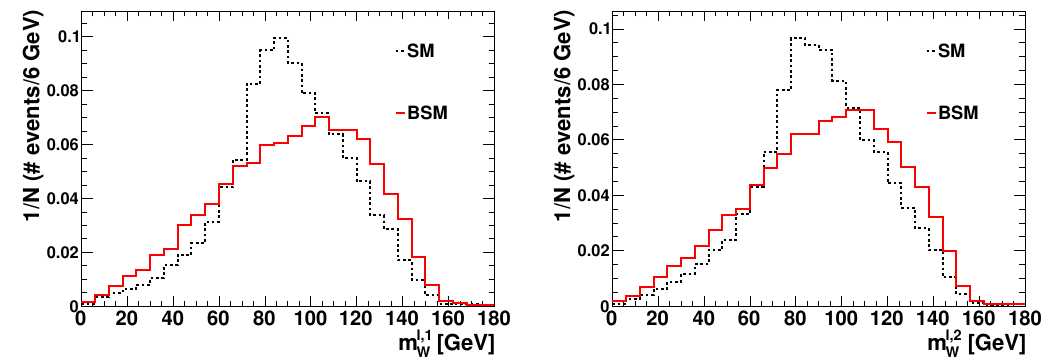
Figure 1 . Reconstructed W -boson mass for the signal (solid red) and background (dashed black). Here 1 (2) refers to the \+" (\ (cid:0) ") solution of the neutrino p z obtained while solving for the invariant mass of the leptonic